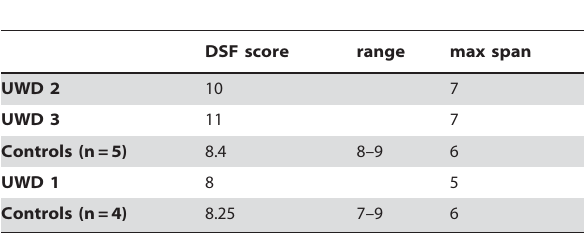
Table 3. Digit Span results for the three UWD subjects and controls from 2003 (Unpublished observations from the study reported in Thornton et al. 2008